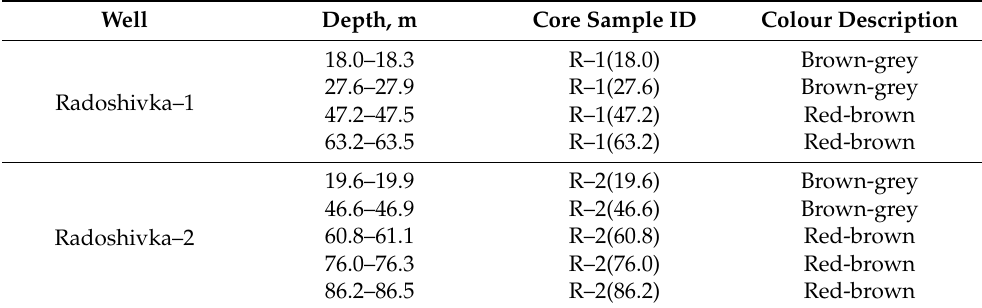
Table 1. Description of the analysed